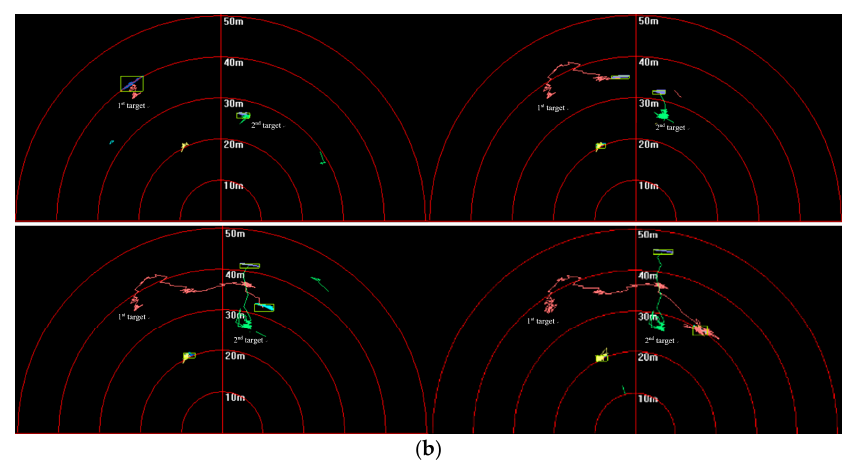
Figure 25. Targets-tracking results in ( a ) first and ( b ) second sequence of FLS images.